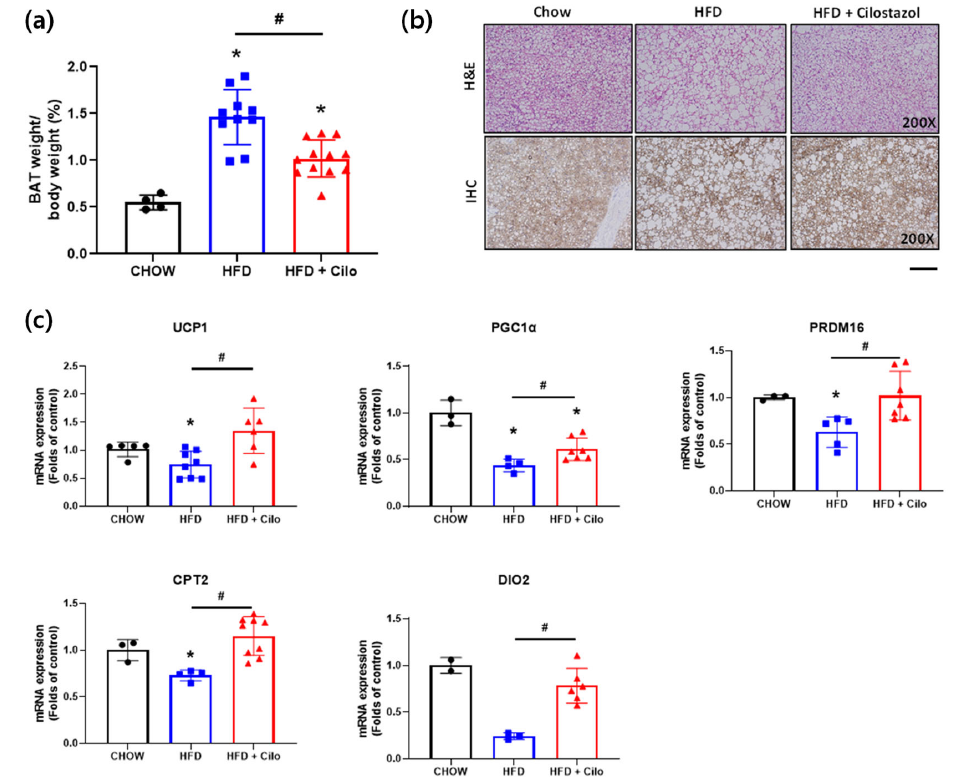
Figure 5. Cilostazol enhanced expressions of brown thermogenic transcriptional factors in brown fat. ( a ) Brown fat weight; ( b ) representative histological images of hematoxylin and eosin (H&E) stained and UCP1 immunohistochemical (IHC) stained (brown) brown adipose tissue section (magnification, × 200, respectively) of Chow control, HFD control and cilostazol-treated HFD mice, respectively; ( c ) relative mRNA expression levels of thermogenesis-related genes in the brown fat. * p < 0.05 vs. corresponding chow control value and # p < 0.05 vs. corresponding HFD control value. HFD, high fat diet; Cilo,